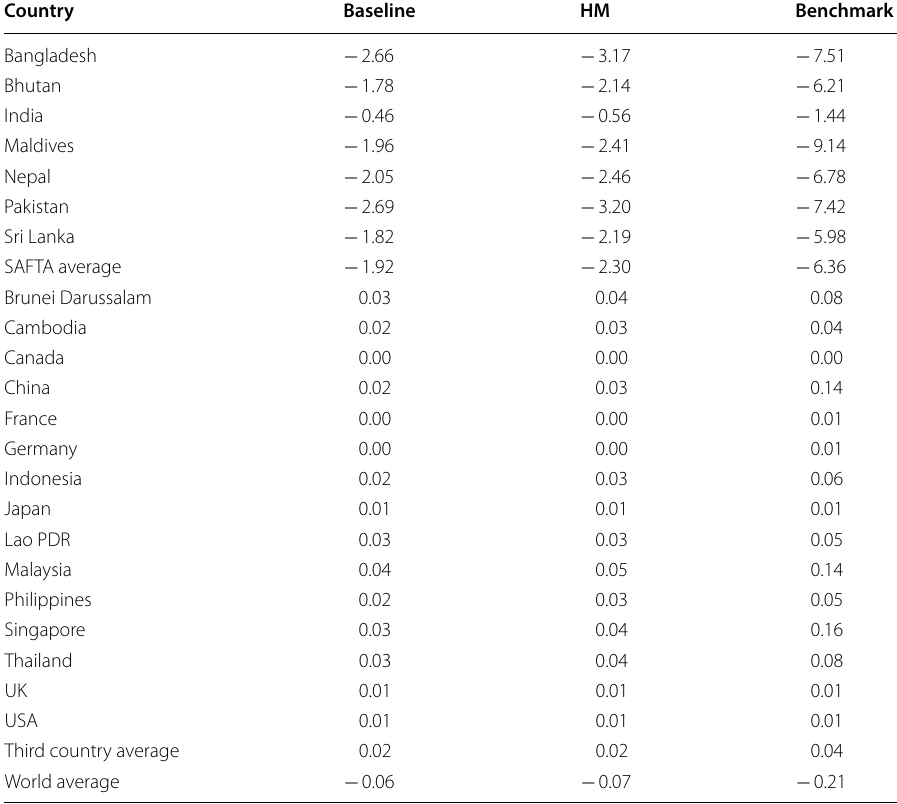
Table 6 Full GE effect of SAFTA, measures from the changes in real GDP. Source Authors’